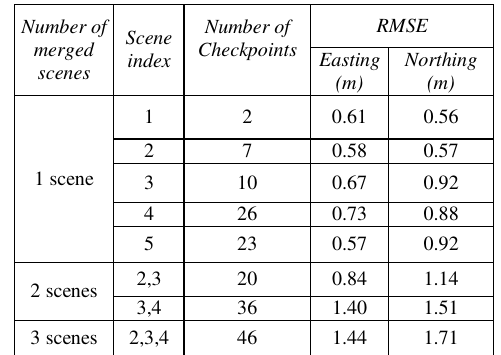
Table 4. THEOS planimetric georeferencing accuracy expressed via RMS discrepancies at ground